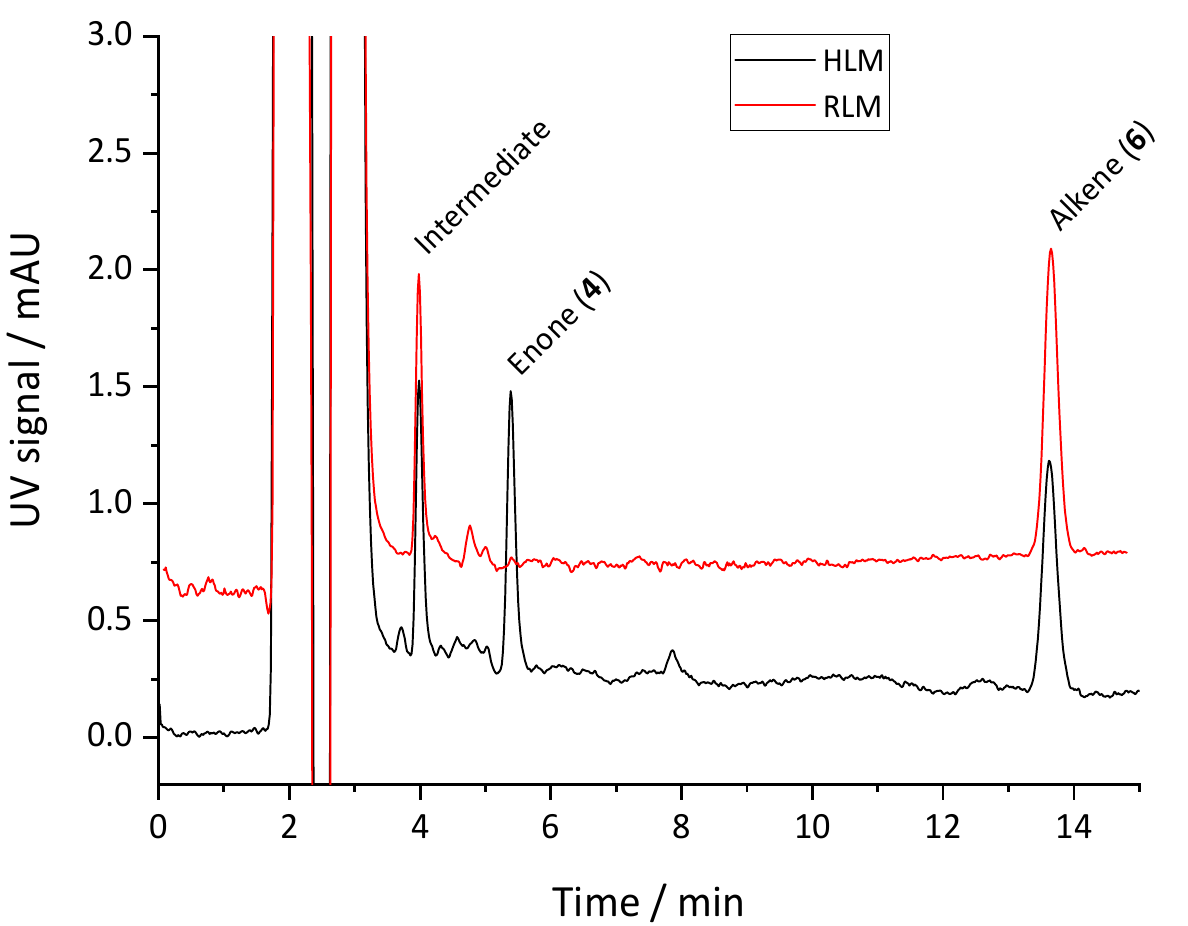
Figure 7. Metabolism of 6 in human (black) and rat (red) liver microsomes. Formation of 4 occurs exclusively in human liver microsomes. Chromatograms were generated at 275 nm and smoothed using a moving average algorithm (filter width 2).